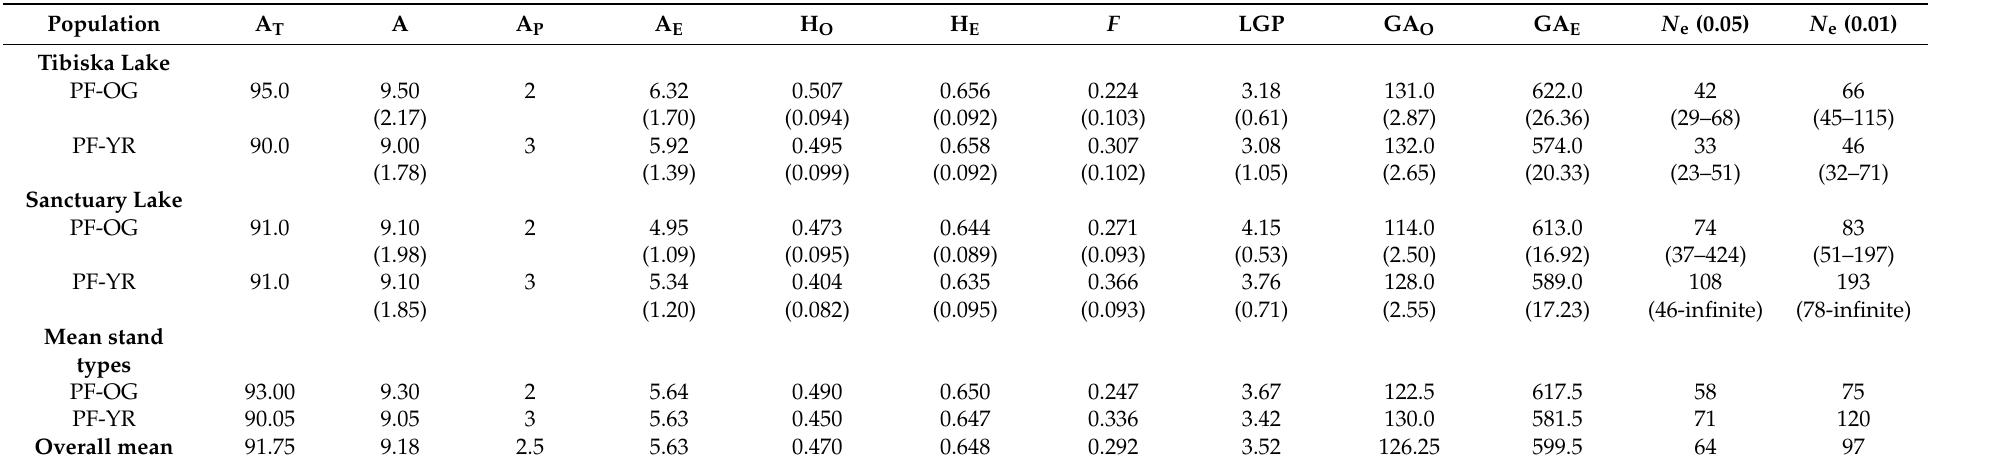
Table 3. Genetic diversity parameters (mean (SE)), inbreeding coefficient, F (SE), and effective population size ( N e ) (95% confidence interval) for the post-fire natural old-growth (PF-OG) and the post-fire young naturally-regenerated (PF-YR) populations of white spruce based on 10 microsatellite